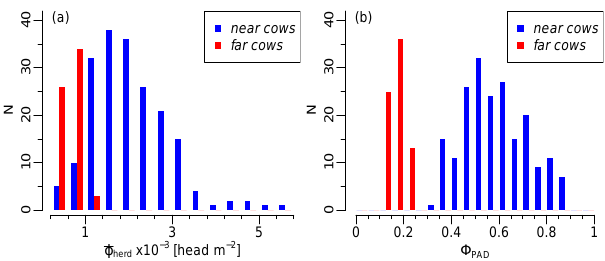
Figure 9. Histogram of footprint contributions (a) of cow positions used in the GPS method and (b) of occupied paddock area used in the PAD method. Cases are separated for distance of the cow herd from the EC tower in near cows and far